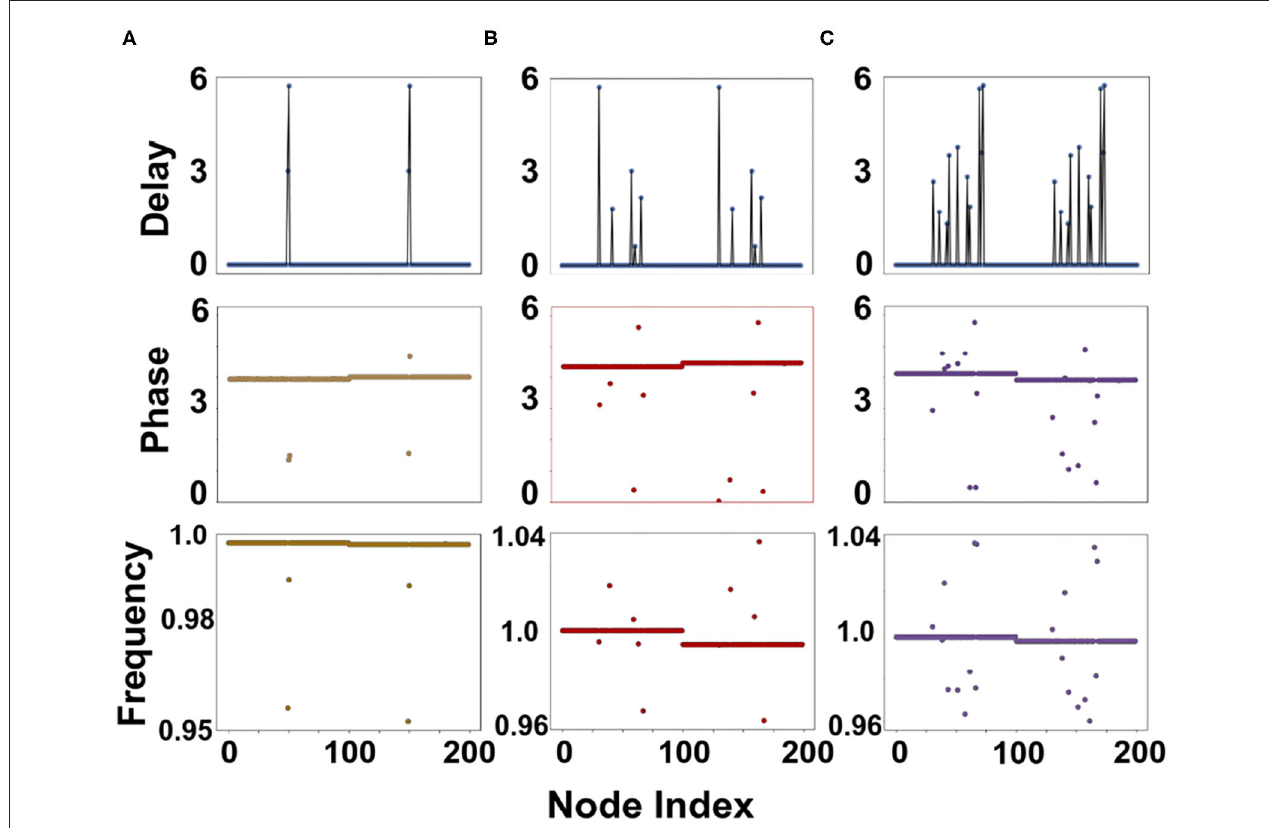
FIGURE 4 | Snapshots of the layers of the multiplex network with (top row) different inter-layer delay profile, resulting in (mid row) Phase; (bottom row) frequency profile for (A) 2- (B) 5- (C) 10- solitary states with the introduced inter-layer delays (as depicted in top row), respectively.